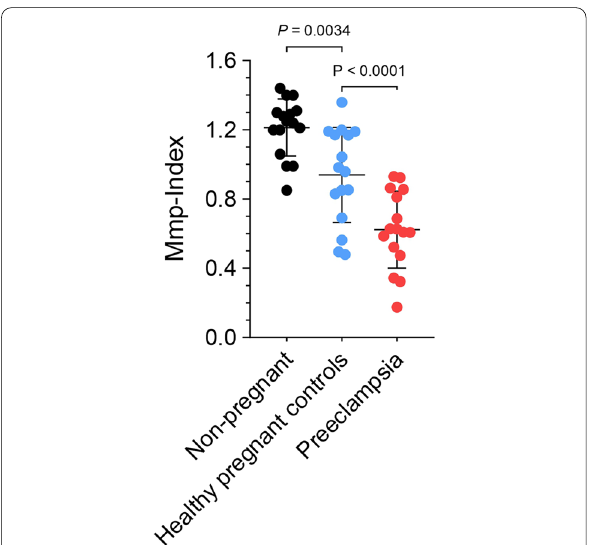
Fig. 1 Platelet mitochondrial membrane potential is decreased in preeclampsia. Mmp-Index of patients with preeclampsia (PE) (n healthy pregnant controls and non-pregnant controls is shown. Mitochondrial membrane potential (Mmp) of platelets from patients with PE is significantly reduced compared to healthy pregnant controls (p < 0.0001). Baseline platelet Mmp-Index of pregnant patients was also significantly lower than in non-pregnant women at baseline (p =